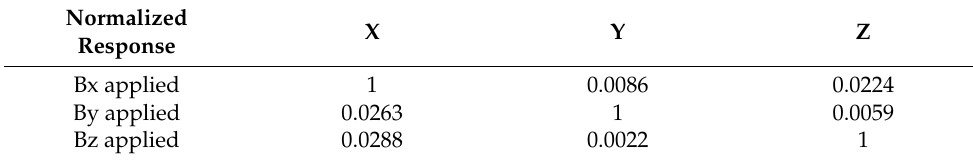
Table 1. Normalized responses in x, y and z direction by the crosstalk effect.